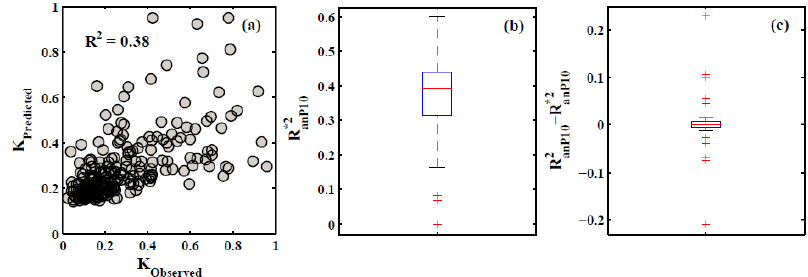
Figure 8. ( a ) Scatter plot between predicted k vs. observed k for basin 02177000 with R 2 as 0.38. ( b ) Boxplot considering the R 2 values from all the study basins. ( c ) Boxplot considering the anP10 anP102∗ values from all the study basin.